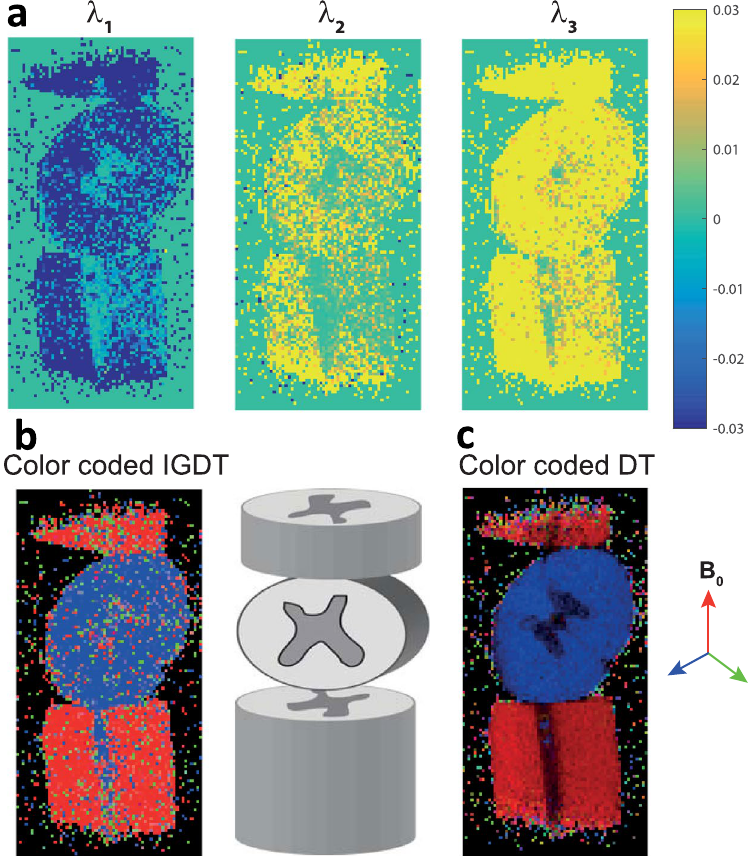
Figure 4. Mapping IGDT in biological tissues. ( a ) IGDT eigenvalues observed for a spinal cord specimen, examined in a 10 mm NMR tube filled with Fluorinert ® (cartoon in center exemplifies this model phantom). ( b ) Color-coded orientation maps generated from the directions of the first eigenvector (the one with lowest eigenvalue) with respect to the main magnetic field [red: z-axis (up-down), blue: x-axis (in-out), green: y-axis (left-right)]. The vector magnitude was weighted with a fractional anisotropy given by = λ three IGDT eigenvalues. Parameters for the NOGSE MRI measurements were: TR / TE = 4000/50 ms, resolution = 156 × 156 × 1000 μ m 3 , six pairs of opposing-gradient NOGSE encodings according to the orientations given in Fig. 3, NA = 4, G = 35 G/cm, total number of NOGSE oscillations of ten, total NOGSE gradient modulation time = 20 ms. A T 2 ~50–60 ms was measured in these white matter experiments, and the shortest delay x was 140 μ s. ( c ) Microscopic DTI tensor determined from the sNOGSE amplitude modulation Δ β S is shown for comparison to demonstrate the consistency of the orientations. EPI sequences were used for collecting all images, the typical SNR was > 35 at its lowest. A full set of measurements took 13 minutes to